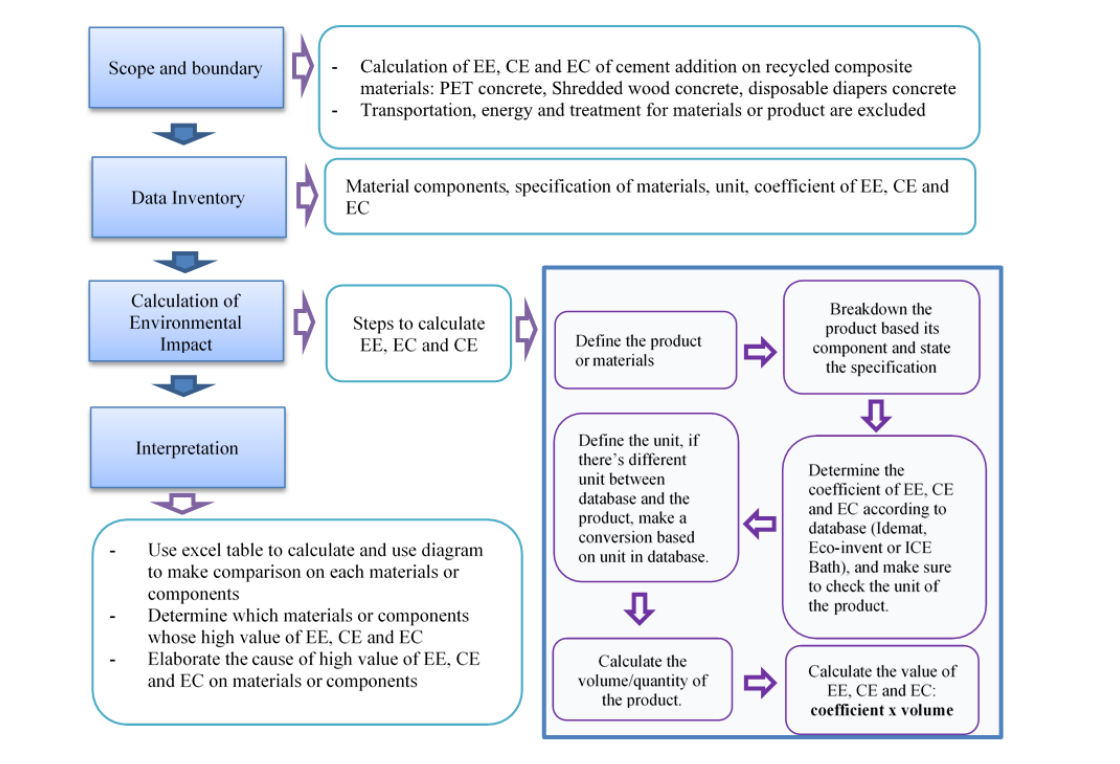
Fig. 2. Research Methodology Flow Chart. Table 1. Materials Composition for 1 m 3 Concrete